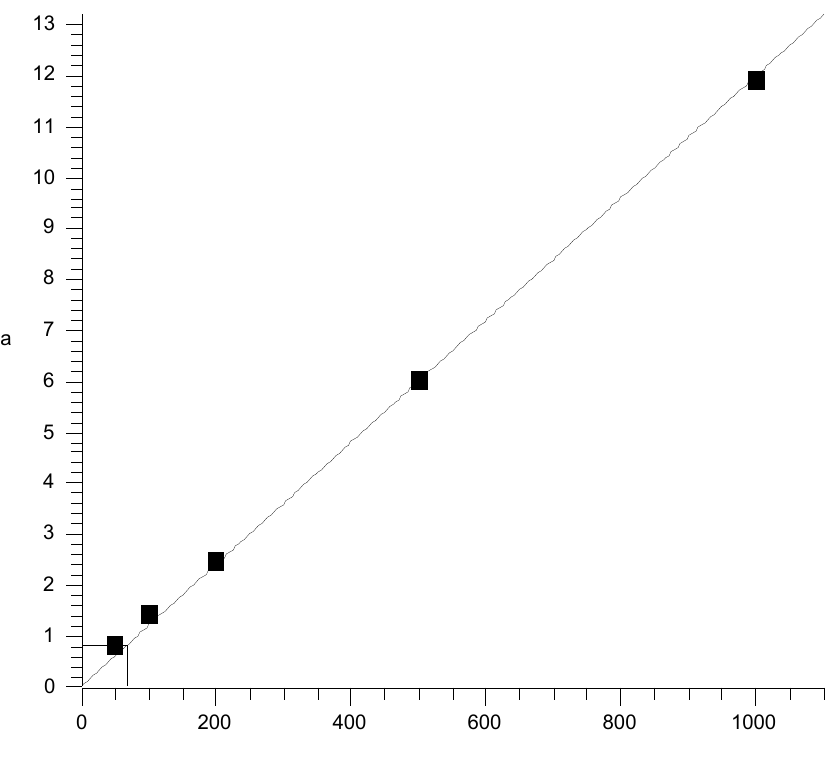
Figure 1. Standard curve about 2-methyl-anthraquinone and peak area.